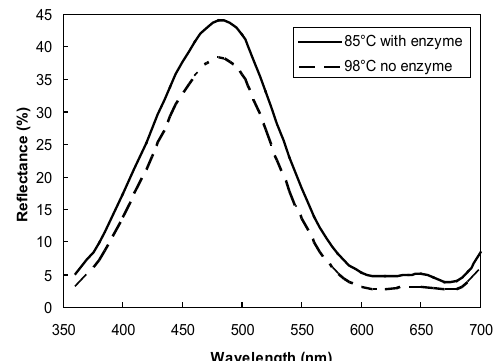
Figure 8. Datacolor spectra for wool fibers dyed with Telon Turquoise and Avolan S.